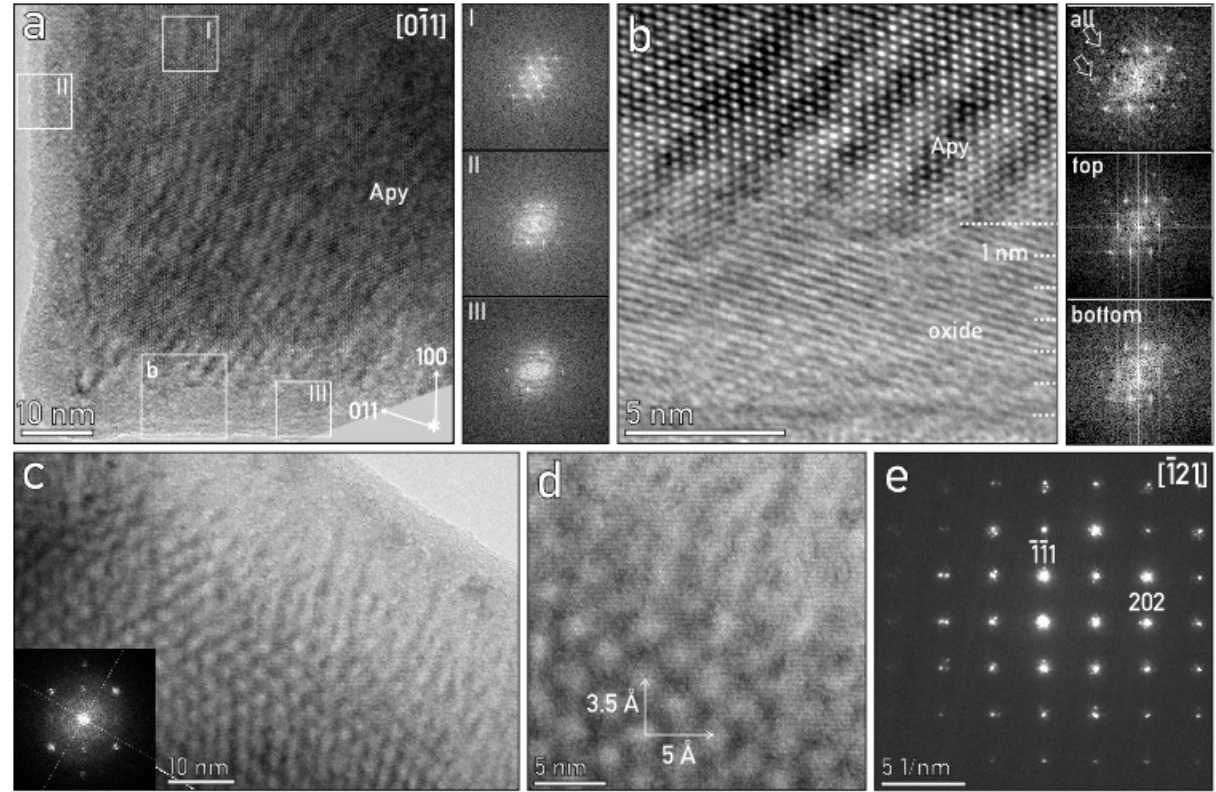
Figure 6. ( a ) Edge of arsenopyrite grain with marked regions for FFT patterns (I–III) and magnified ( b ) HR-TEM micrograph of the surface layer with corresponding FFT power spectra. ( c ) Overview TEM micrograph with corresponding FFT pattern, and ( d ) magnified detail with marked apparent 3.5 Å × 5 Å superlattice. ( e ) SAED pattern recorded over the same region, showing satellite reflections around each main diffraction peak. The main SAED pattern is indexed for arsenopyrite, and the additional oxide diffraction spots are slightly smaller due to the expanded unit cell parameters.